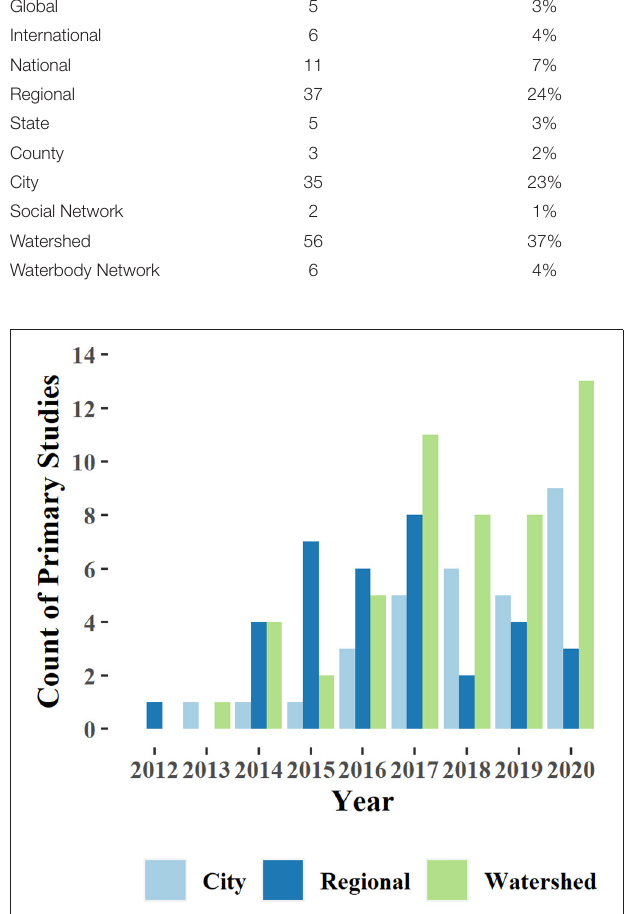
FIGURE 4 | Count of the primary studies’ three most common spatial extents by year of publication between 2012 and 2020.